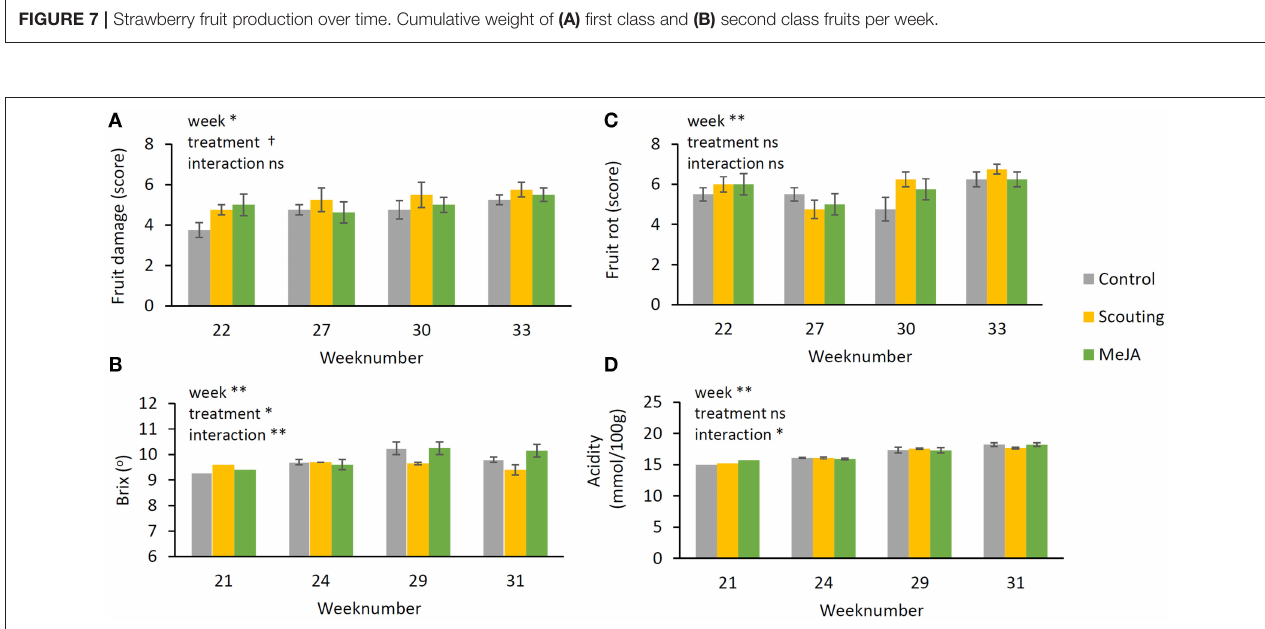
FIGURE 8 | Shelf lives and tastes of harvested strawberry fruits during the production period. Shelf life was scored (A) fruit damage and (B) fruit rot. Scores are three: not acceptable, five: acceptable, seven: good. Data present mean ± SEM ( n = 8). Taste was evaluated by determining the two most important components for sweetness (C) Brix ( ◦ ) and (D) acidity (titratable acid in mmol/100g fresh weight). Data present mean ± SEM (taste n = 1 for week 21 (mix of fruits of all eight blocks per treatment), n = 2 for weeks 24, 29, 31 (mix of fruits of 4 blocks per treatment). Significant differences are indicated as * p ≤ 0.05, ** p ≤ 0.01, based on GLM using a Wald chi-squared